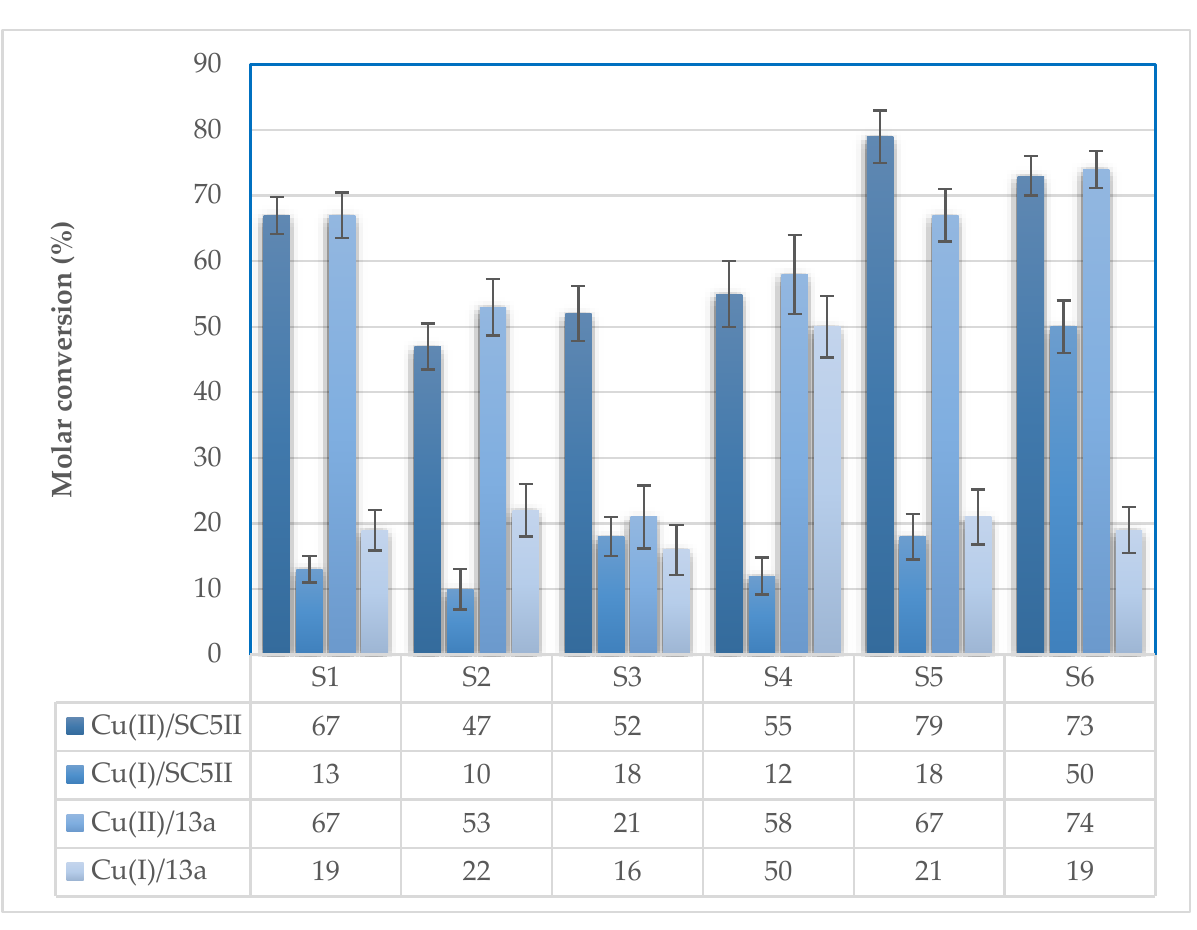
Table 1. Catalytic reactions under an inert atmosphere in comparison to an air one. The enantio- meric excess was evaluated by HPLC equipped with chiral column (Lux Cellulosa 4) [14]. Bacteria Atmosphere